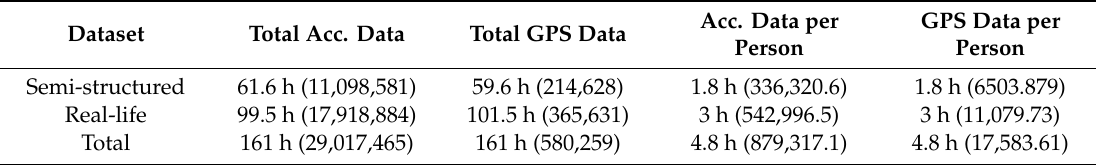
Table 1. Labeled data collected for the study.